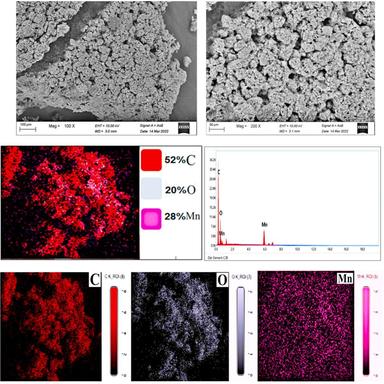
SEM and EDX mapping of mesoporous (MnO2/MWCNT).